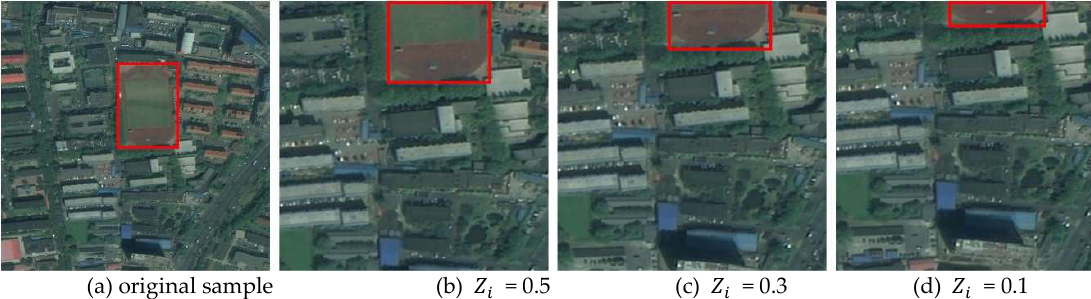
Figure 16. Visualization of “zoom in” operation, the track and field is inside the red box: ( a ) The original sample; ( b ) The data-enhanced sample after 0.5× “zoom in”; ( c ) The data-enhanced sample after 0.3× “zoom in”; ( d ) The data-enhanced sample after 0.1× “zoom in”.